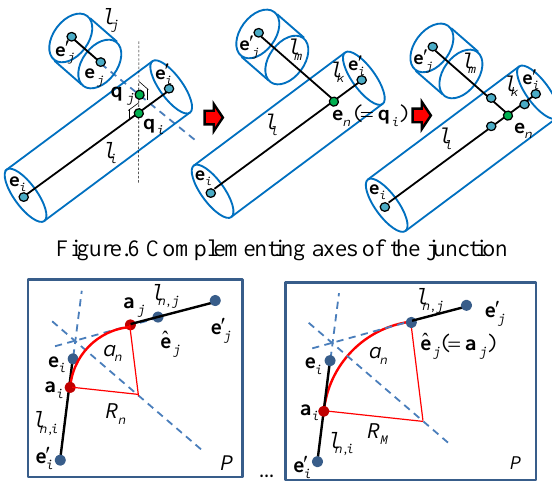
Figure.7 Complementing axes of the